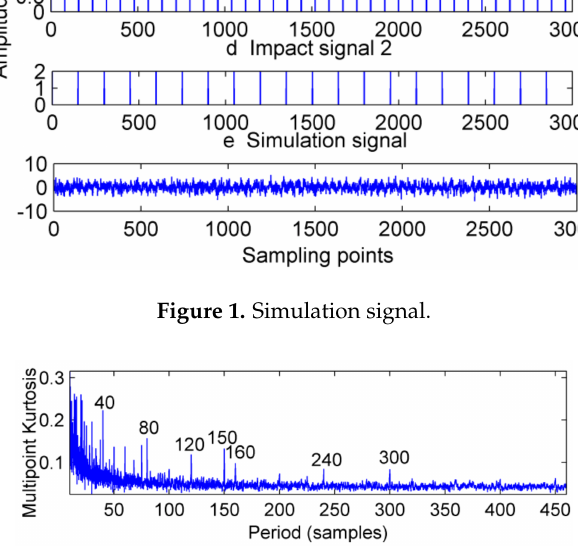
Figure 2. MKurt spectrum of simulation signal under low